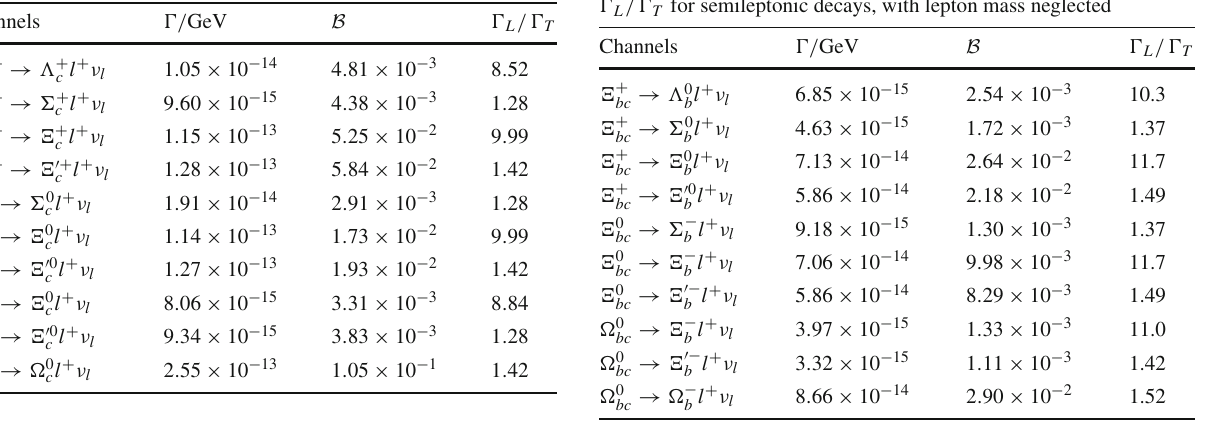
Table17 The bb sector:decaywidths,branchingratiosandthe (cid:14) L /(cid:14) T for semileptonic decays, with lepton mass neglected Channels